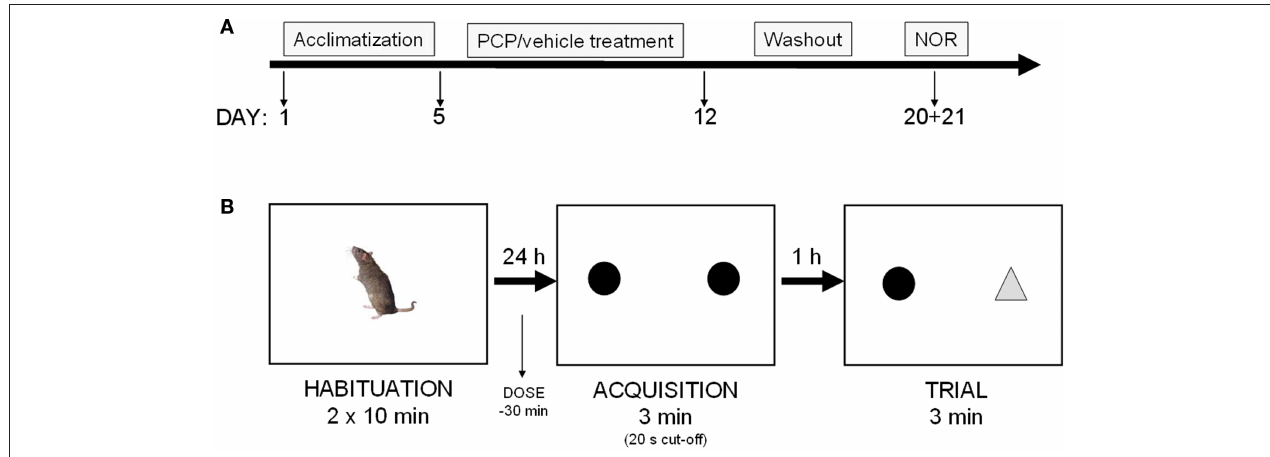
Figure 1 | (A) Experimental schedule: rats were treated for 7 days with vehicle or PCP (5 mg/kg, IP, b.i.d) before a 7-day washout period. Rats were then exposed to the novel object recognition paradigm (NOR), on days 8 + 9 following last PCP injection. (B) NOR: rats were treated with vehicle or test compound as outlined in the “Materials and Methods” section, and the time spent exploring a novel and familiar object was